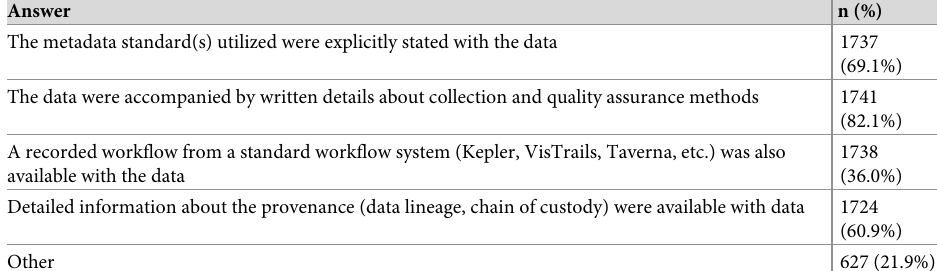
they use no metadata standard (“None”) (35.9%), and nearly a quarter said they use "Metadata standardized within my institution/lab" (24%). The use of a metadata standard differed significantly by sector of employment (Chi- Square = 53.532; p = .000). Government employees are most likely to use some metadata stan- dard (54.9%), followed by respondents working in the commercial sector (43.4%). In the aca- demic, non-profit and other sectors, only about a third of respondents were using a specified metadata standard.